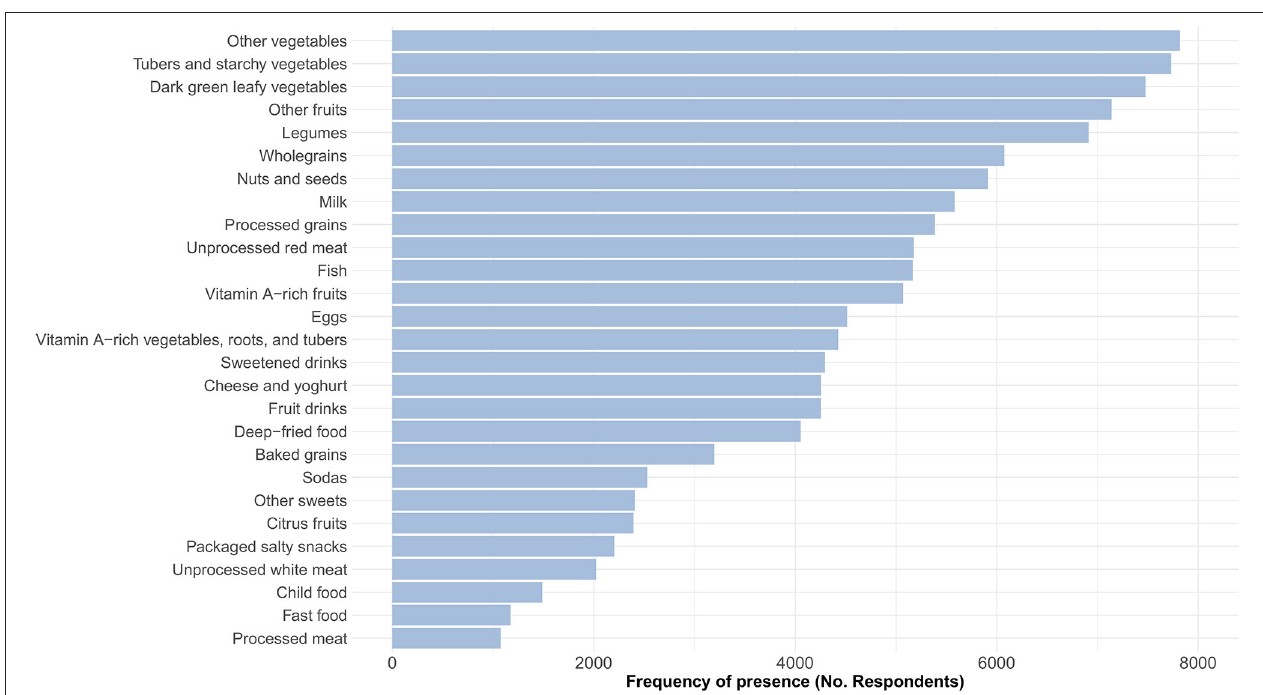
FIGURE 4 | Frequency of presence of food groups in Rwandan respondents’ diets. Food groups are derived from the Diet Quality Questionnaire.